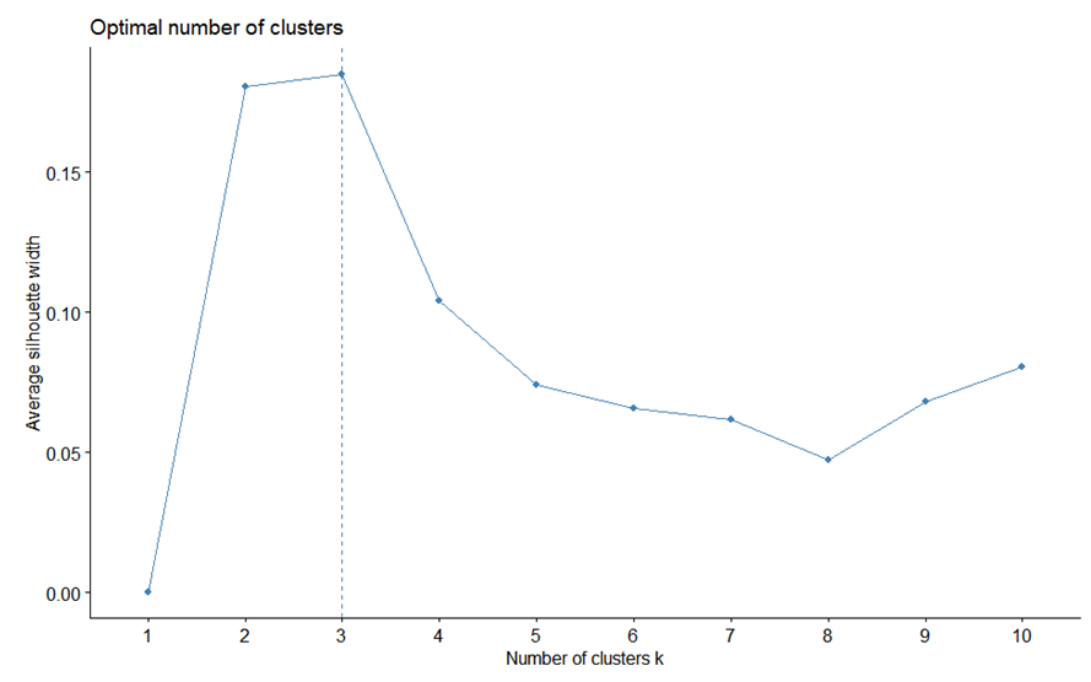
Figure 5. The optimal number of clusters for the analysis of fish larvae and juveniles in the waters around Taiwan from 2007 to 2019. The dotted line indicates the optimal number of clusters, which is located at the point where the number of clusters (x-axis) corresponds to the largest average silhouette width (y-axis).